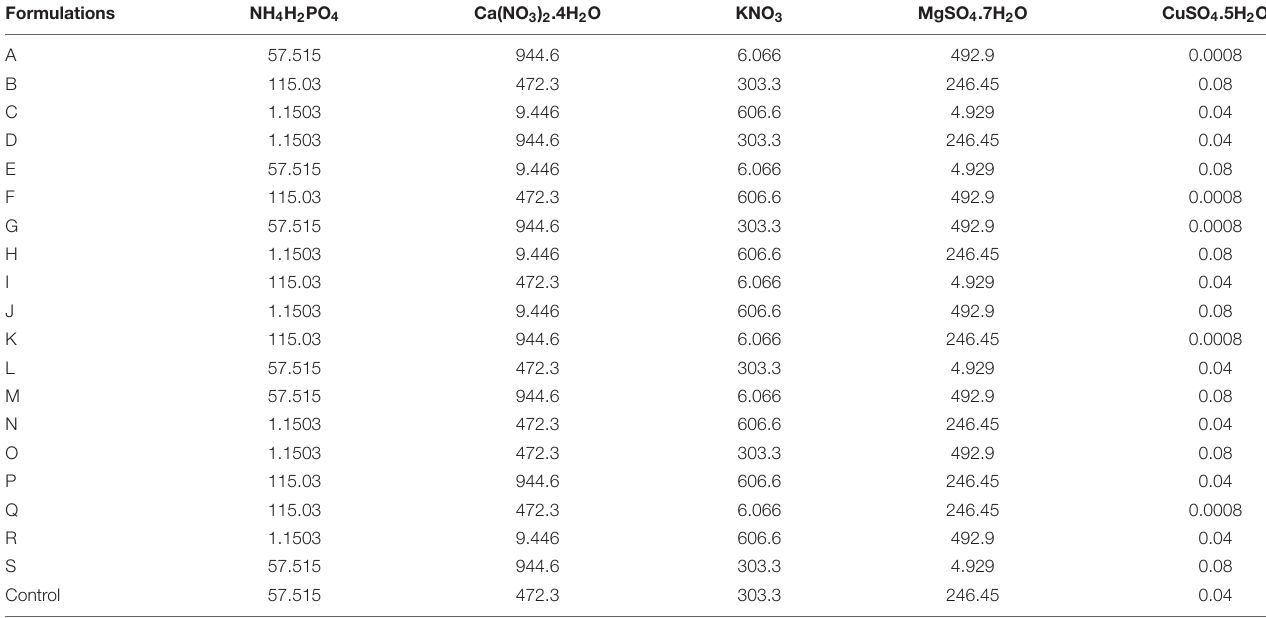
TABLE 1 | Composition of the mineral formulations established by the five-factor design (19 treatments) based on Hoagland mineral nutrients plus half strength of Hoagland solution (as control) in mg/L. Formulations